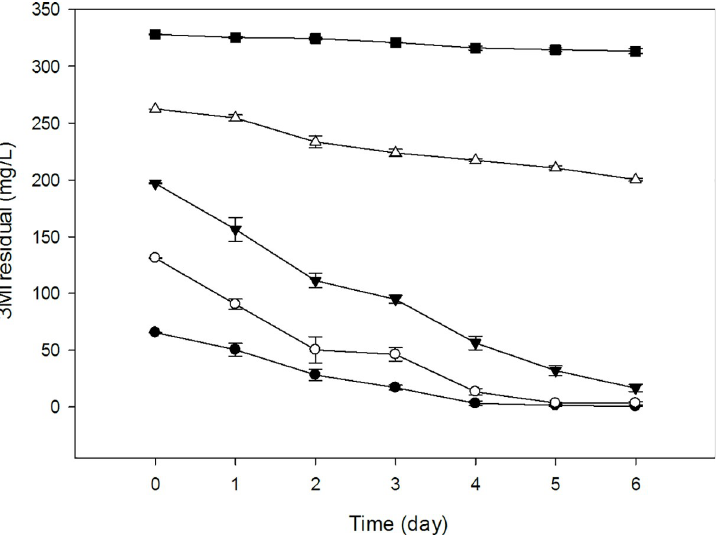
Fig 8. 3MI removal capability of TAT1-6A strain at different initial concentrations (mg/L). Symbols: solid circle, 65.58; open circle, 131.17; solid triangle, 196.75; open triangle, 262.34; solid square, 327.92; Error bars, mean ± SE of three riplicates; at T = 31˚C and pH